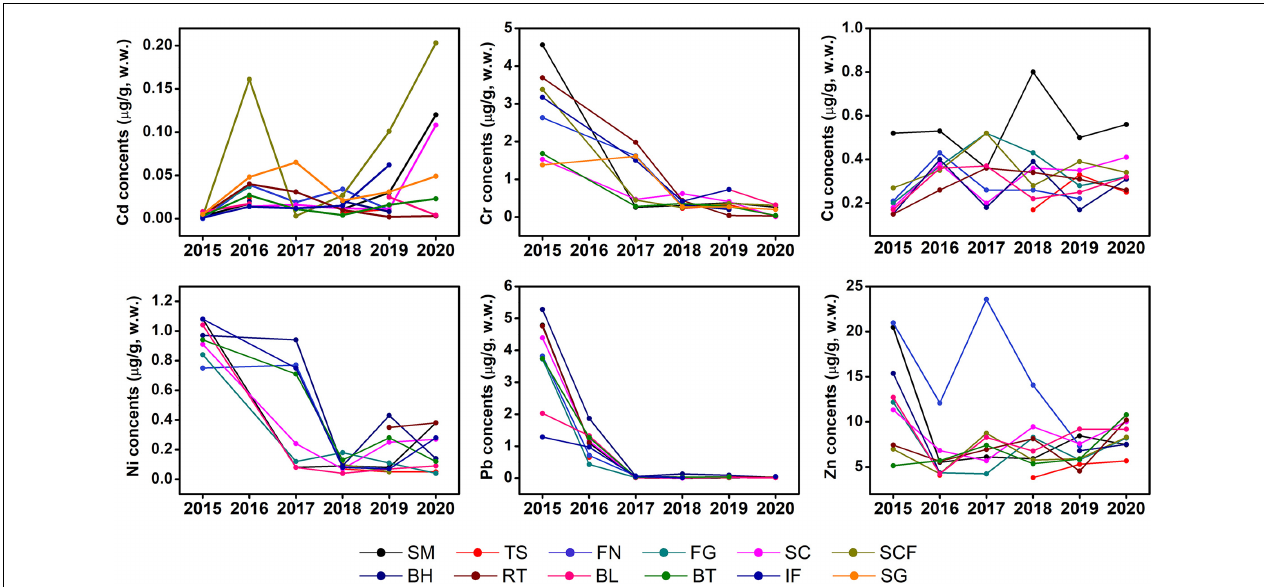
FIGURE 3 | Interannual variations of mean concents of trace metals ( µ g/g, w.w.) in muscle tissues of marine fish in Liaodong Bay from 2015 to 2020. SM: Spanish mackerel; TS: Tongue Sole; FN: Flat needlefish; FG: Fang’s gunnel; SC: Sea chub; SCF: Sea catfish; BH: Bastard halibut; RT: Robust tonguefish; BL: Bluefin leatherjacket; BT: Black tetra; IF: Indian flathead; SG: Shokihaze goby.